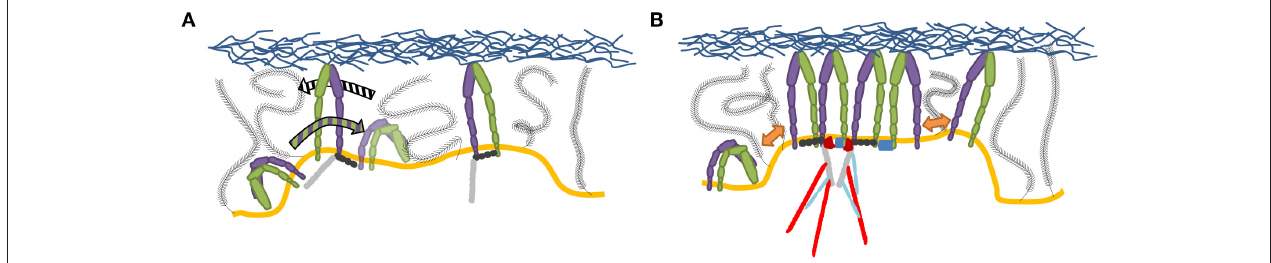
FIGURE 4 | Current picture of integrin clustering. (A) Initial liganded integrins create a region with increased integrin binding probability, by membrane and glycocalyx deformation, which effectively attracts integrins while pushing out the glycocalyx. (B) Clustering is further amplified by multivalent ligands, dimerizing adaptor proteins, established scaffolding structures through cytoplasmic factors as well as TMD interactions (Gingras and Ginsberg, 2020).